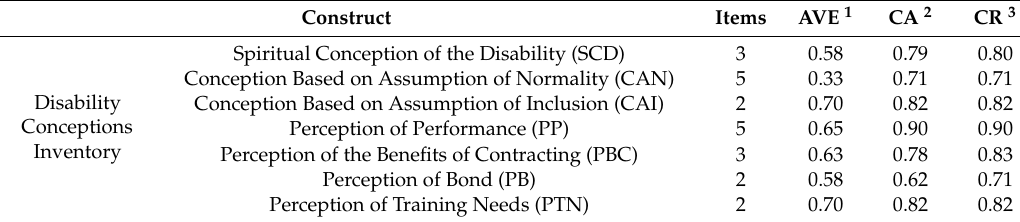
Table 1. Convergent validity and reliability.